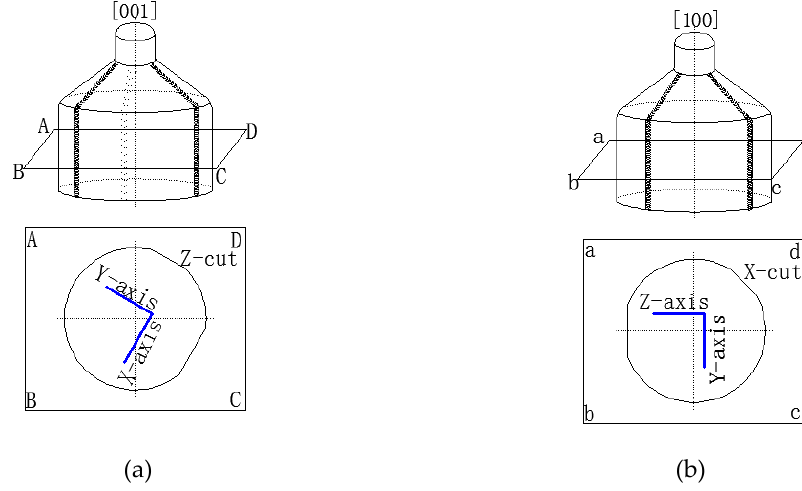
Figure 1. CSM Tribo-Indenter and the specimen.